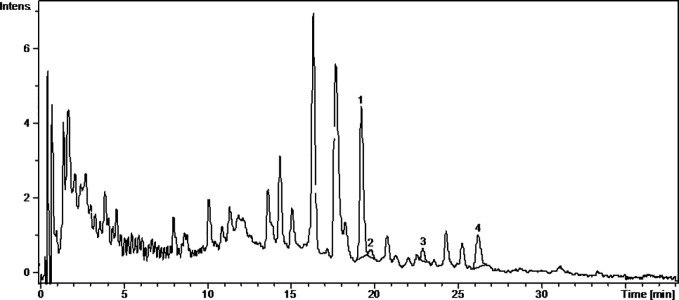
The UV chromatogram of fresh Pinot noir 2015 grape pomace extract. 1, Isoquercitrin; 2, Rutoside; 3, Quercitrin; 4, Quercetin.